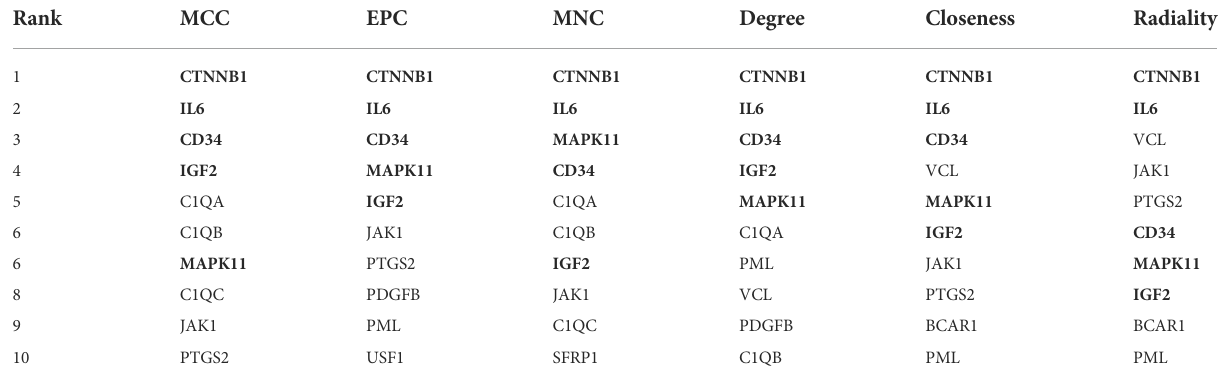
TABLE 1 Screening of hub genes using six algorithm in cytoHubba.